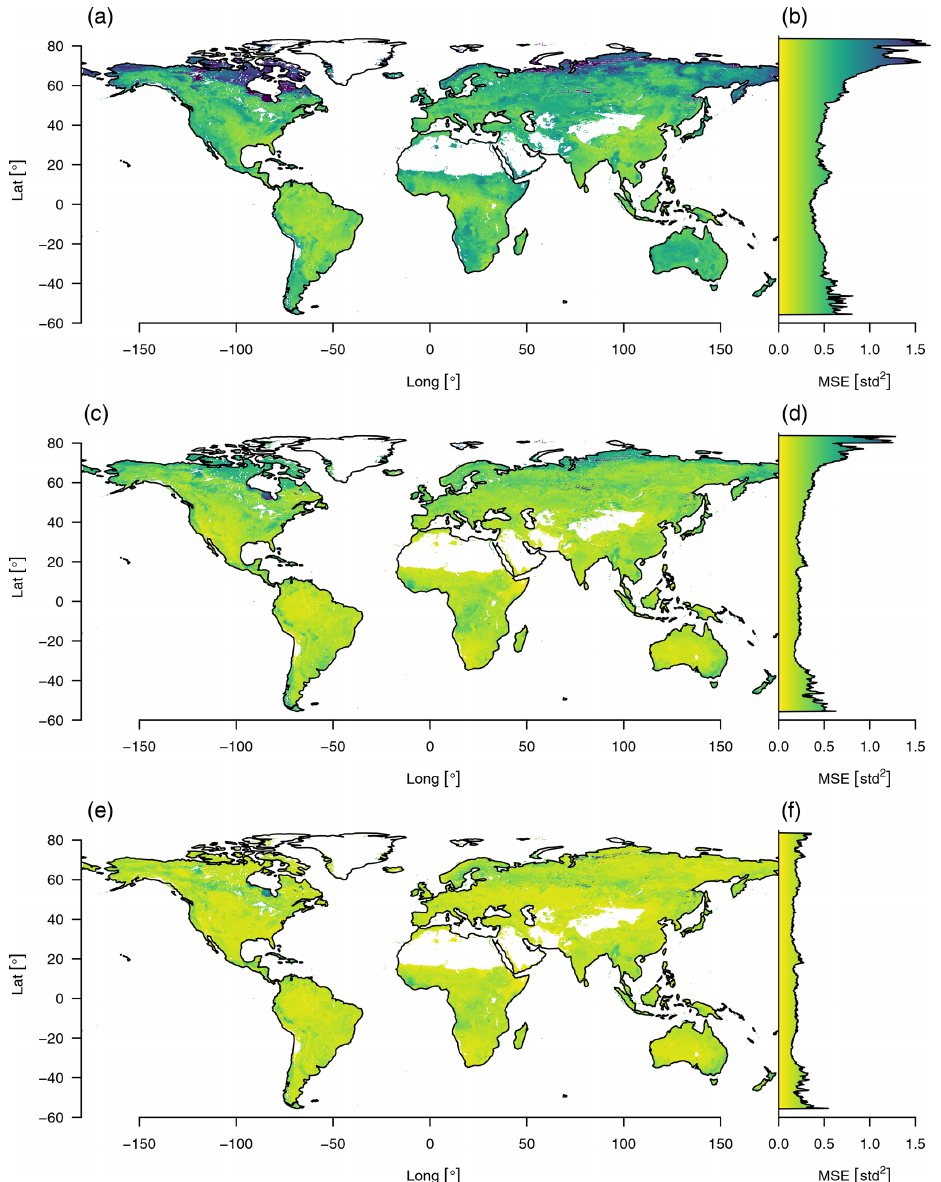
Figure 3. Reconstruction error of the data cube using varying numbers of principal components aggregated by the mean squared error. Reconstruction errors aggregated over all time steps and variables are shown in the left column: (a) using only the first component, (c) using the first two, (e) and using the first three. Corresponding right plots (b, d, f) show the mean reconstruction error aggregated by